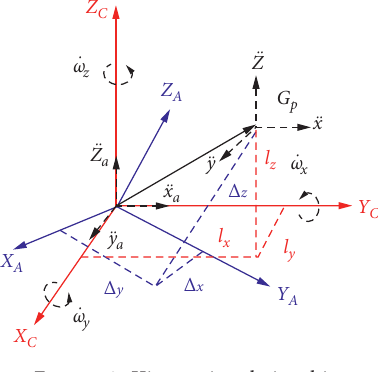
Figure 2: Kinematic